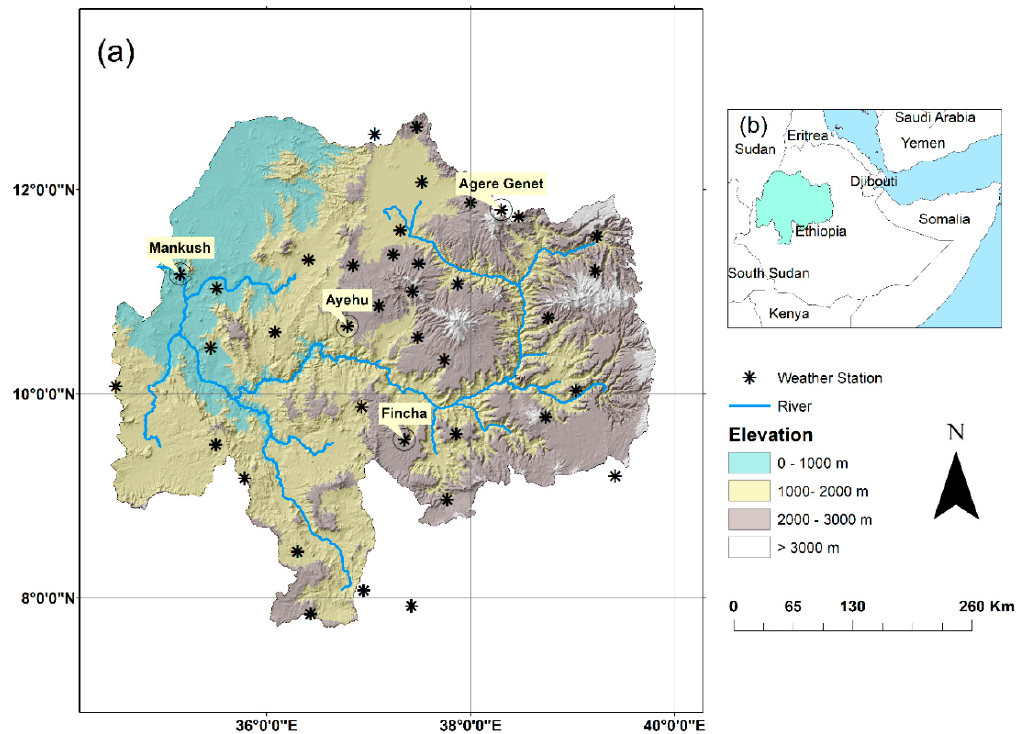
Figure 1. Study area. ( a ) Digital elevation map of the Upper Blue Nile River Basin (UBNRB) and the location of 38 selected rain gauges. ( b ) Inset map showing the location of the study area. Encircled and labeled stations in ( a ) are used for monthly time series plots in Section 3.2.